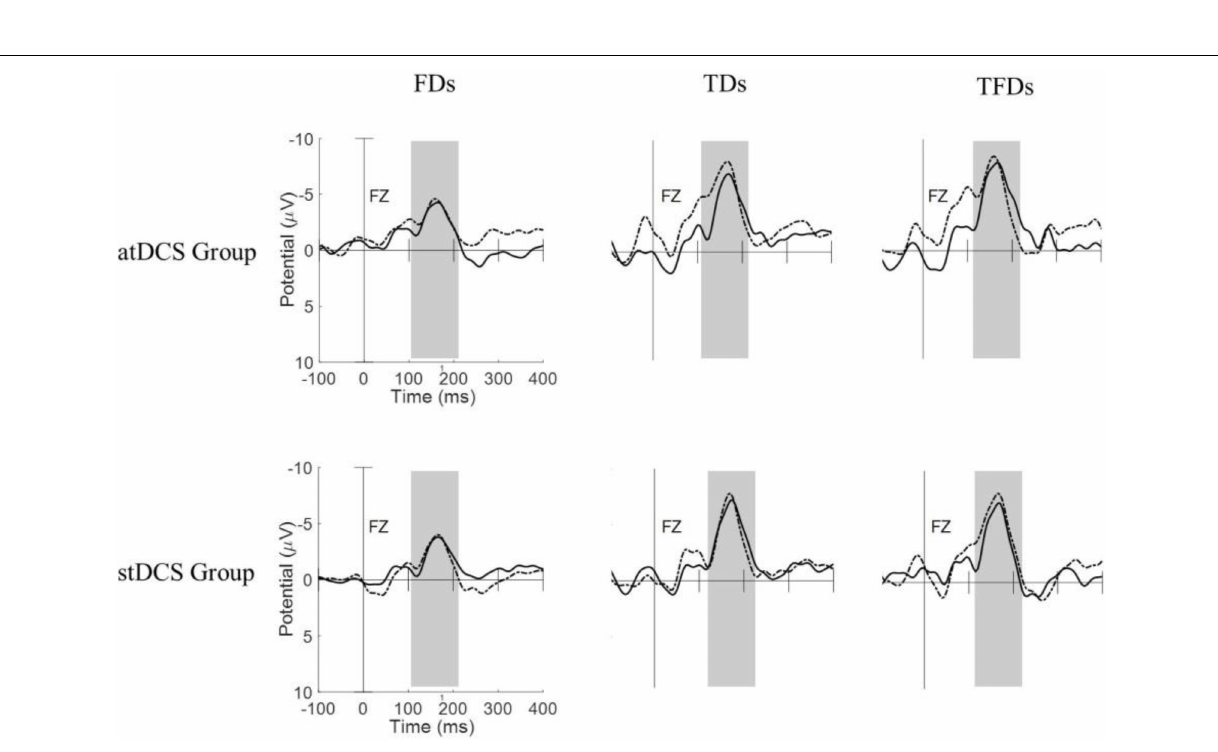
FIGURE 2 | Grand averages of MMNs for all subjects of each group under the three types of deviation stimuli. Dashed line = pre-tDCS, solid line =